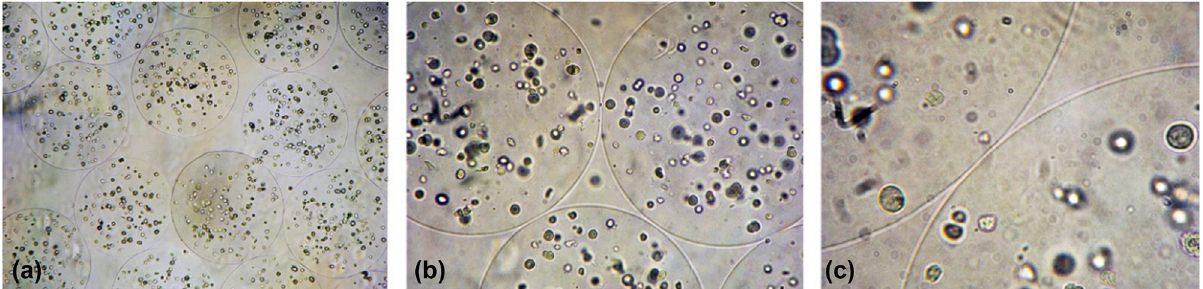
Figure 3: The alginate hydrogel beads with encapsulate MC3T3 - E1 cells. ( a ) × 40 magni fi cation; ( b ) × 100 magni fi cation; ( c ) × 250 magni fi